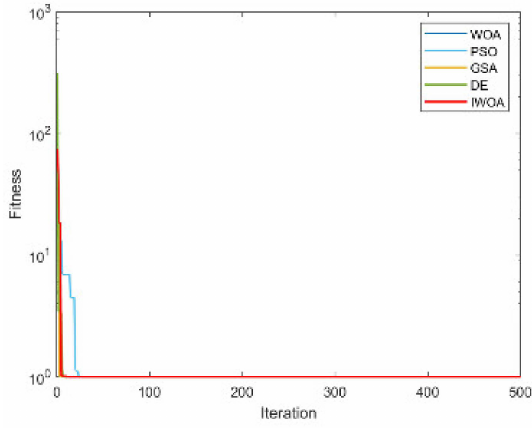
Figure A9. The convergence curve for solving F9.